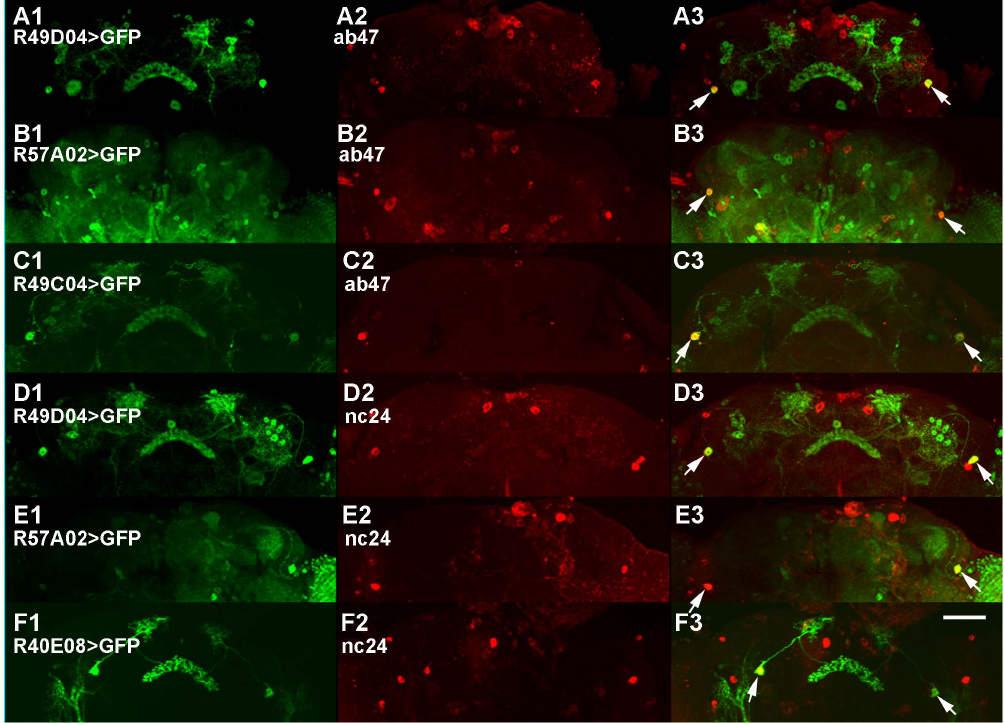
Figure 5. Examples for the co-localization of staining by mAbs ab47 (A-C) and nc24 (D-F) and GFP driven by selected Janelia Gal4 lines. Due to the variability of cell body positions in different individuals it is only suggestive that the Gal4 expression patterns overlap. Scale bar 100 m m.